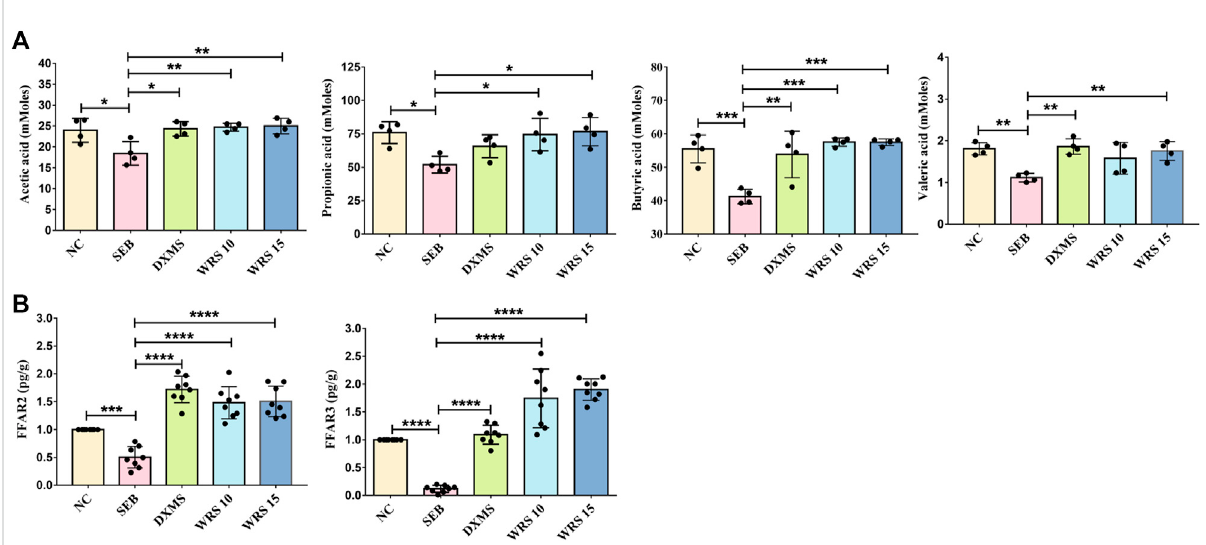
FIGURE 3 Effects of WRS on short-chain fatty acids in mice. (A) Change of content of acetic acid, propionic acid, butyric acid and valeric acid (n = 4). (B) ChangeofmRNAexpressionofFFAR3andFFAR2( n